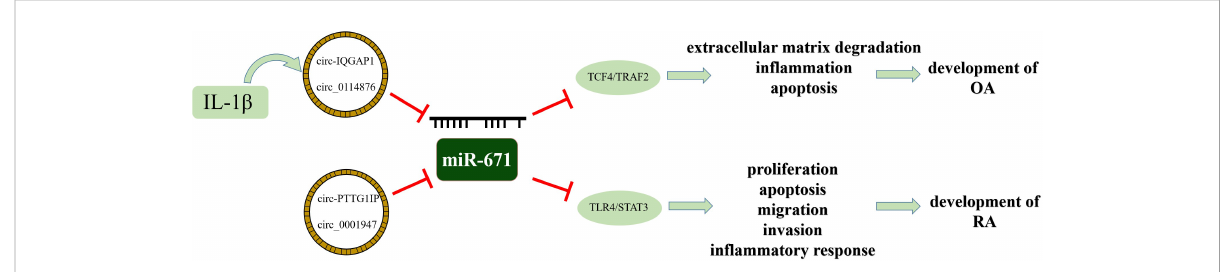
FIGURE 4 The schematic diagram of the involvement of the circRNA-miRNA-mRNA axis in OA and RA